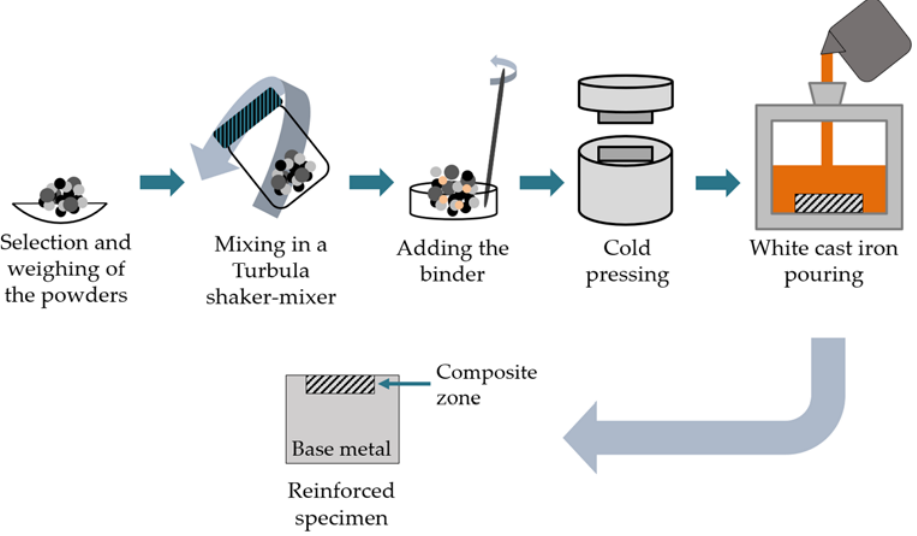
Figure 1. Schematic view of the fabrication steps for the production of reinforced samples (adapted from [15]).